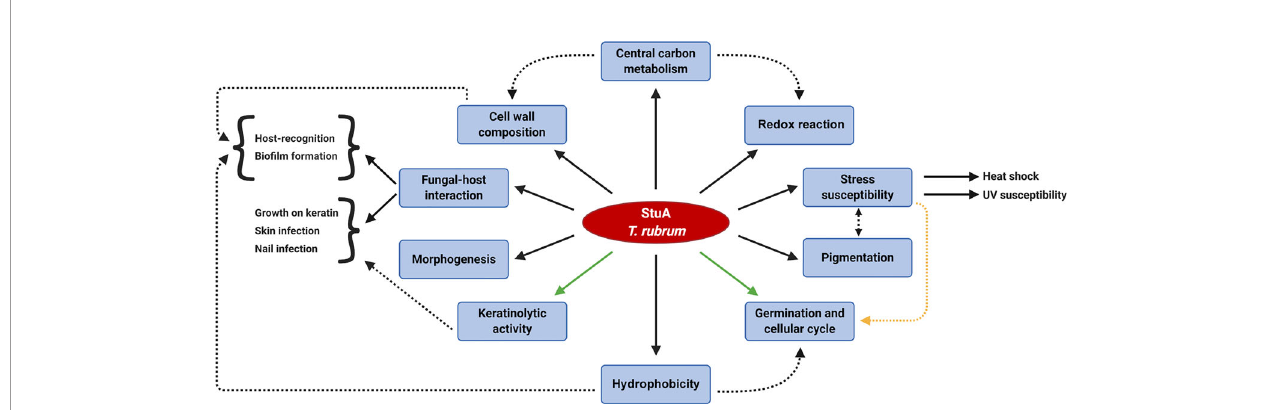
FIGURE 6 | Schematic overview of the biological processes potentially regulated by StuA in the dermatophyte Trichophyton rubrum . The regulation of central carbon metabolism is cross-related to other StuA targeted-processes. Dashed arrows indicate a correlation between some downstream effects. Interwoven pathways yet to be elucidated might involve turning in and off some routes, such as the control of keratinolytic activity and the germination rates (green arrows). A conceivable hypothesis of the regulation of germination rates and cell cycle is associated with a stress response mechanism (yellow dashed